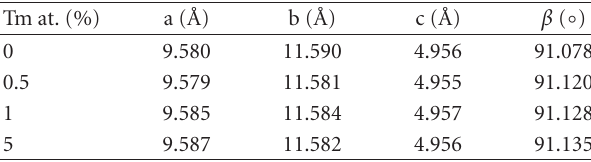
Table 1: Calculated unit cell parameters for various thulium concentrations.